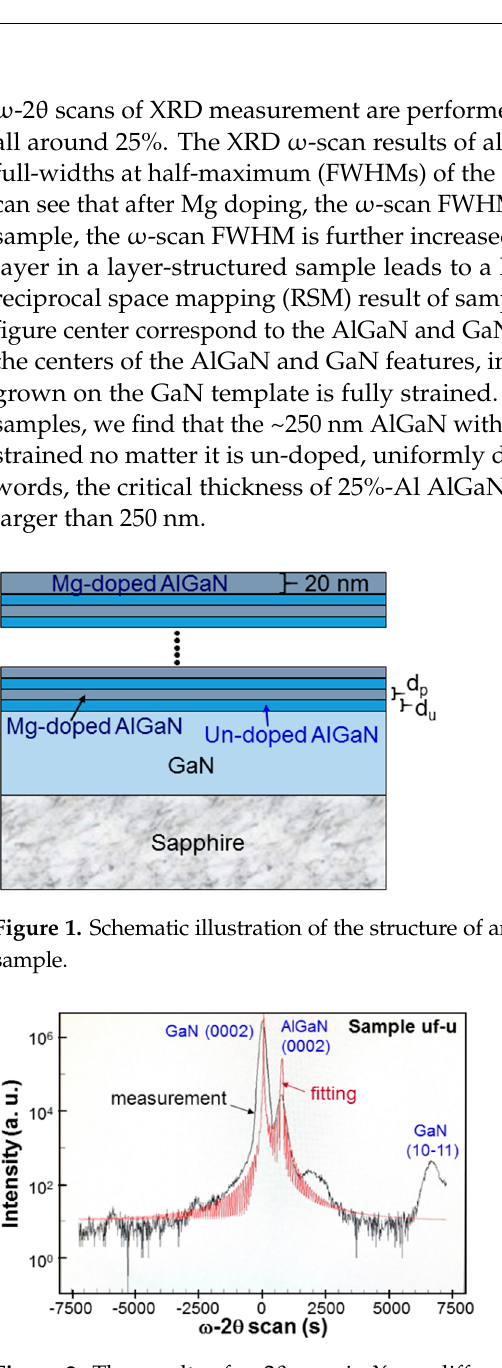
Figure 1. Schematic illustration of the structure of an Mg-doped/un-doped AlGaN layer-structured sample.